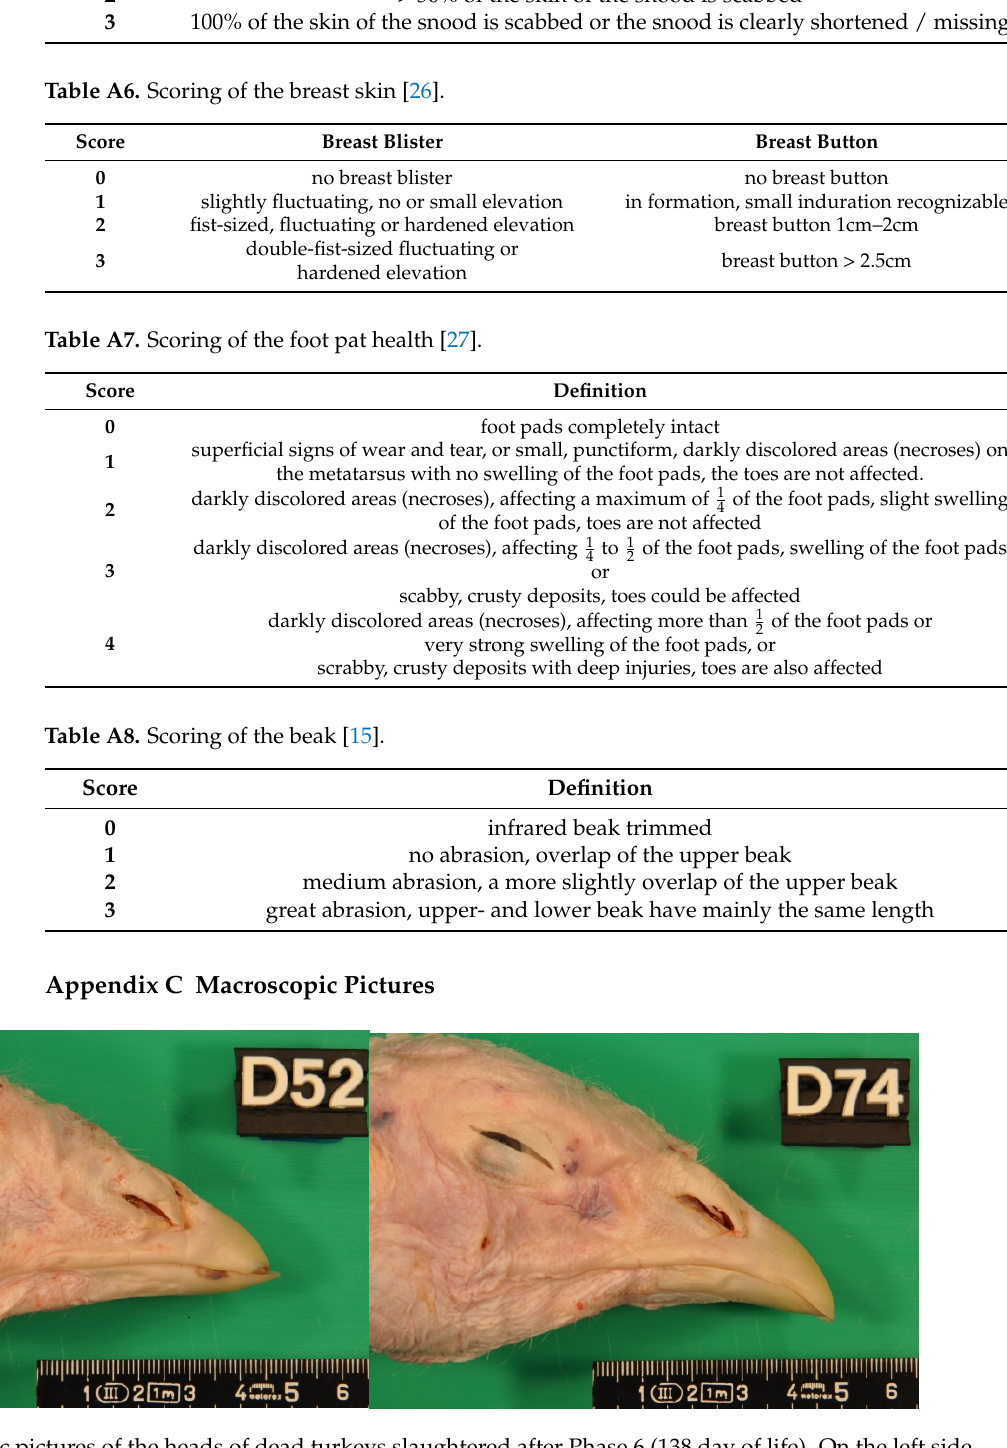
Figure A2. Macroscopic pictures of the turkey heads (also seen in Figure 1) which were split lengthwise with a band saw. On the left side (D52) is an infrared beak trimmed turkey and on the right side (D74) is the head of a turkey which had an integrated screed grinding wheel in the feed pan. . Figure A3. Macroscopic pictures of the head of a dead turkey of our preliminary study, slaughtered after Phase 6 (147 day of life) which was not beak-trimmed and without an integrated screed grinding wheel in the feed pan. On the left side the whole head can be seen and on the right side this head was split lengthwise with a band saw.